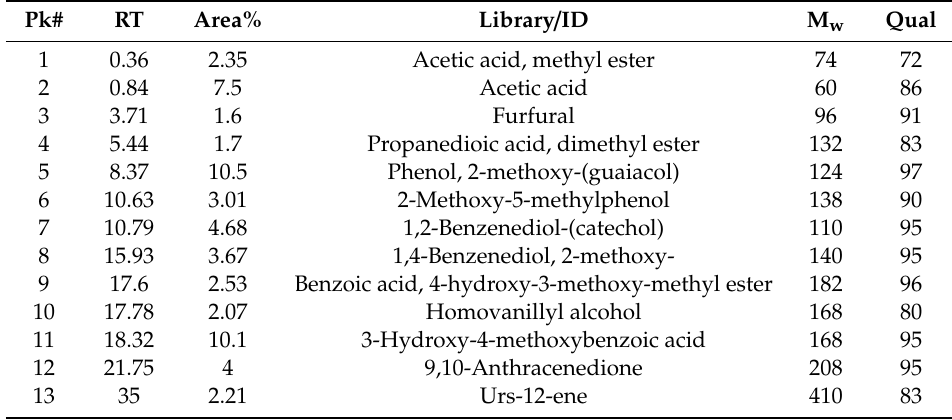
Table 3. Py–GC / MS analysis results for the DKL product from oxidative de-polymerization of SKL at room temperature at a 1:1 H 2 O 2 / SKL mass ratio.